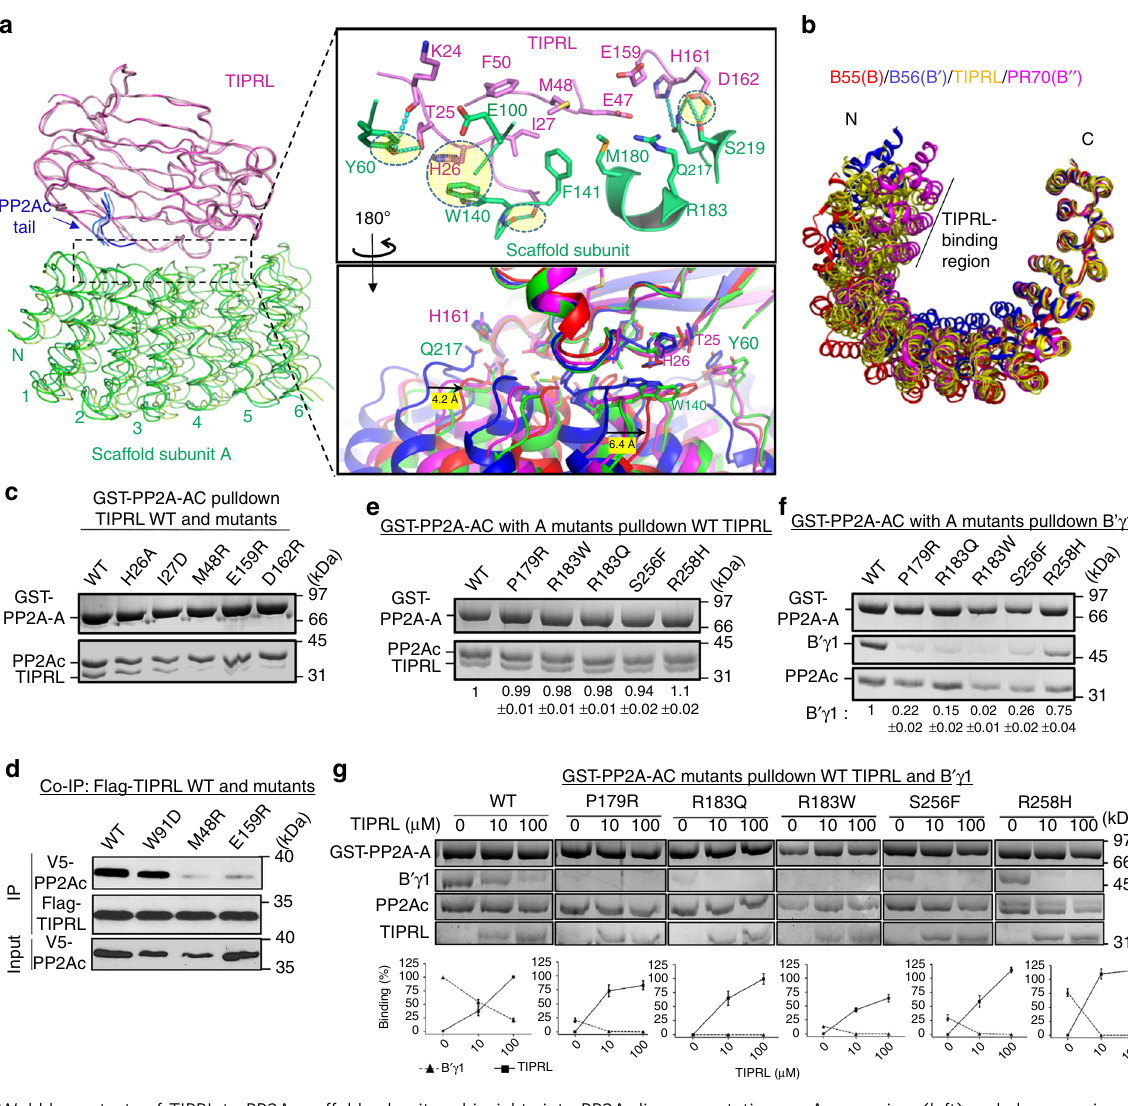
Fig. 5 Wobble contacts of TIPRL to PP2A scaffold subunit and insights into PP2A disease mutations. a An overview (left) and close-up views (right) of interactions between TIPRL and the scaffold A subunit. The left overview shows the overlay of the four asymmetric copies of the complex in ribbon with the same color scheme as the upper panel of Fig. 1. The N-terminal six HEAT repeats of the scaffold subunit were shown. The upper right close-up view shows a representative interface in cartoon and colored as in overview. Key residues at the interface are shown in sticks. The wobble contacts are highlighted in circles. The bottom right close-up view shows the overlaid interfaces of all four asymmetric copies of the complex colored in blue, cyan, green, and red. The blue and red copies differ the most among the four copies. b Overlay of PP2A scaffold subunit in four asymmetric copies of the TIPRL-bound complex (yellow) and in different holoenzymes, PP2A-B55 α (red, PDB code: 3DW8), PP2A-B ’ γ 1 (blue, PDB code: 2NPP), and PP2A-PR70 (magenta, PDB code: 4I5L). The HEAT repeats that are involved in interaction with TIPRL are indicated by the length of a black line. c Pulldown of wild-type (WT) and mutant TIPRL by PP2A core enzyme containing GST-A. Proteins associated with GS4B resin were examined on SDS-PAGE. d Co-immunoprecipitation (Co-IP) of WT and mutant Flag-tagged TIPRL with V5-tagged PP2Ac. Pulldown of e TIPRL, f B ’ γ 1, and g B ’ γ 1 with titrated concentrations of TIPRL, by PP2A core enzyme containing WT or mutant GST-A. The mutations in the scaffold A subunit were found in cancer and intellectually disabled patients. Proteins associated with GS4B resin were examined on SDS-PAGE. The relative amount of TIPRL ( e , g ) and B ’ γ 1 ( f , g ) associated with PP2A core enzyme were normalized to PP2A-A and then quanti fi ed as the ratio to or percentage of the normalized amount of proteins bound to the WT PP2A core enzyme in the absence of competitor. The quanti fi ed results were presented as mean ± s.e.m. and shown at the bottom of the gel ( e , f , g ) and plotted as